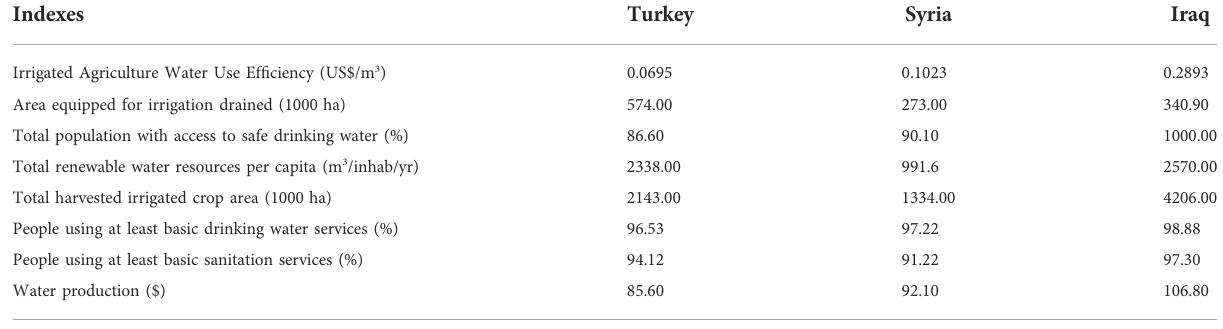
TABLE 7 Water ef fi ciency data for the three countries.